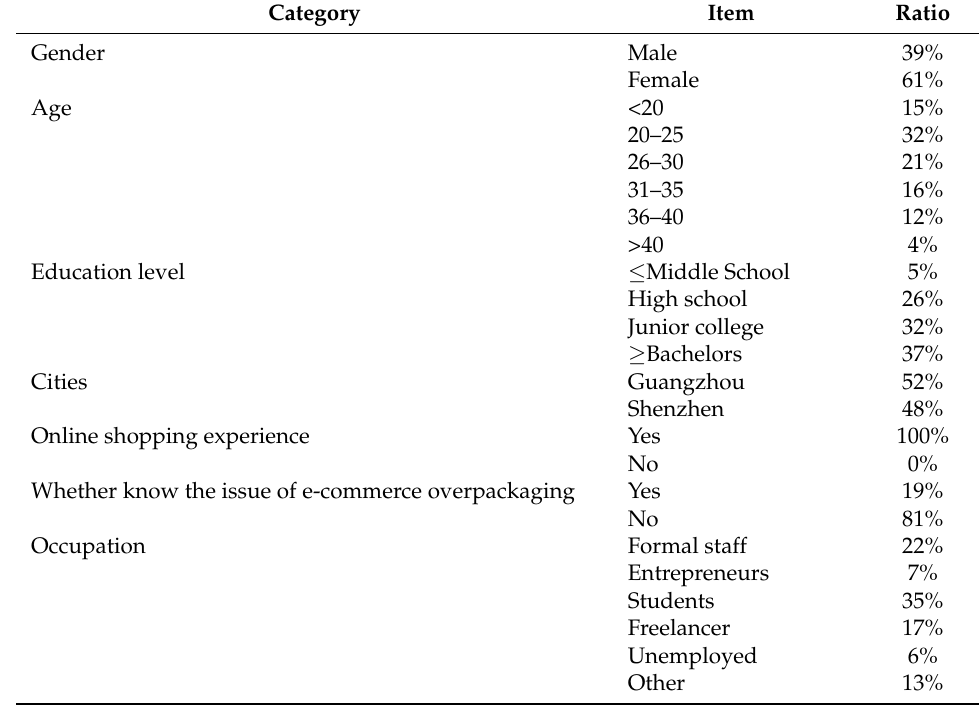
Table 3. Descriptive statistics of the respondents’ necessary